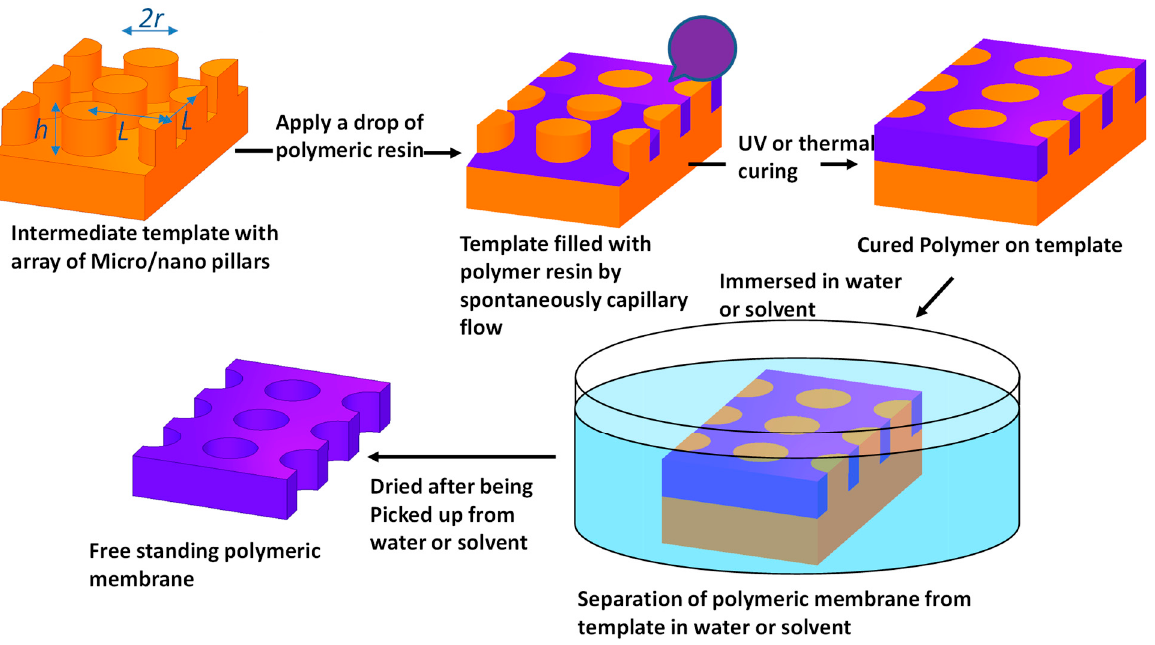
Figure 1. Process flow chart to make polymeric membranes via an intermediate template and SCF filling. The polymeric membrane is separated from the template by dissolving the template in deionized water (PVA template) or by swelling-based lift-off in solvent-assisted separation (Zeonor 1060R template).